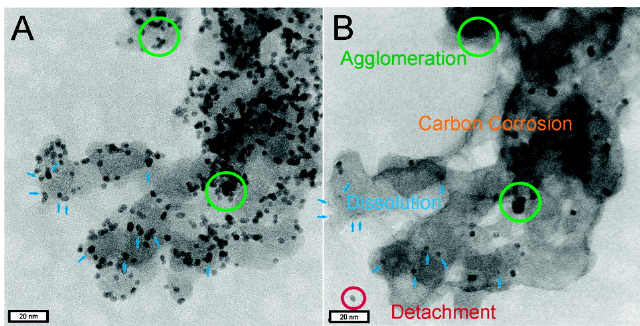
Fig. 16. – In their study, Meier et al. managed to find idential locations of a platinum nanoparticle for TEM imaging before and after successive electrochemical tests. This way, they were able to study and quantify catalyst degradation mechanisms for these materials. Figure reproduced with permission from